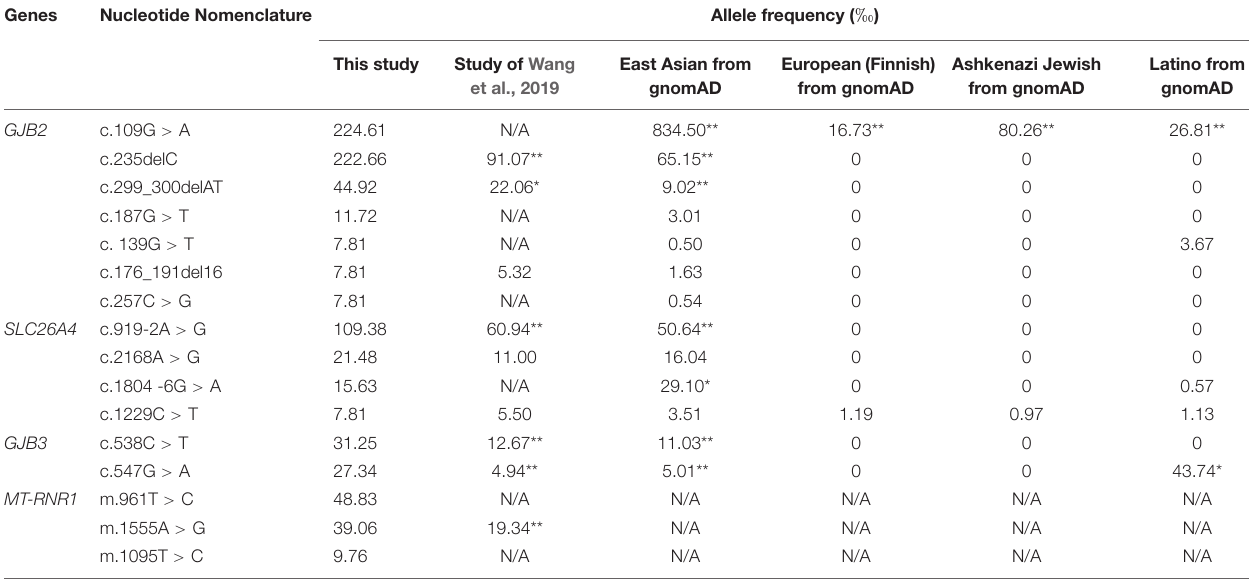
TABLE 8 | The frequency of the pathogenic/likely pathogenic variants (more than four loci) in this study.